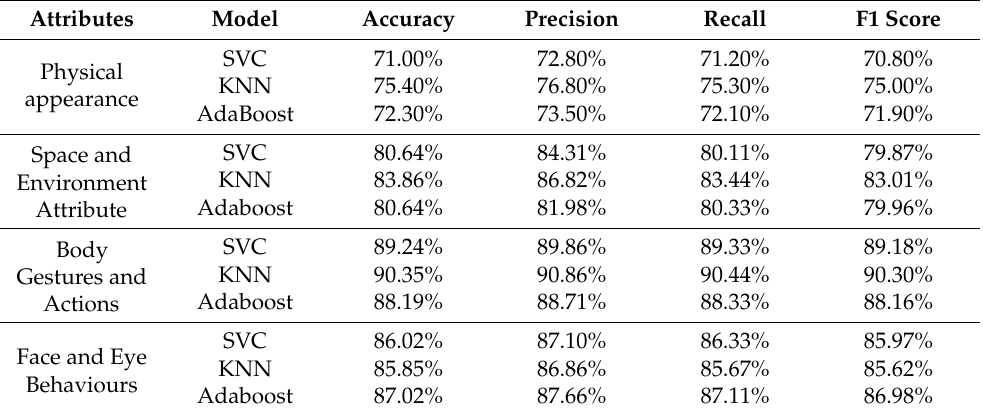
Table 23. Results for each set individually.